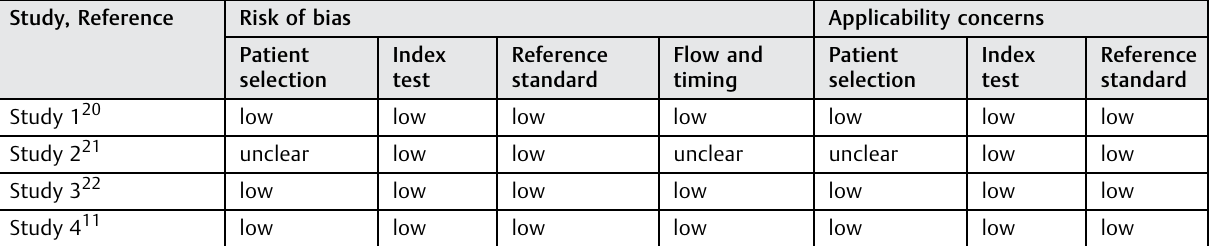
Table 3 Risk of bias of the trials assessed by Quandas-2 as a standardized tool for quality assessment of studies of diagnostic accuracy